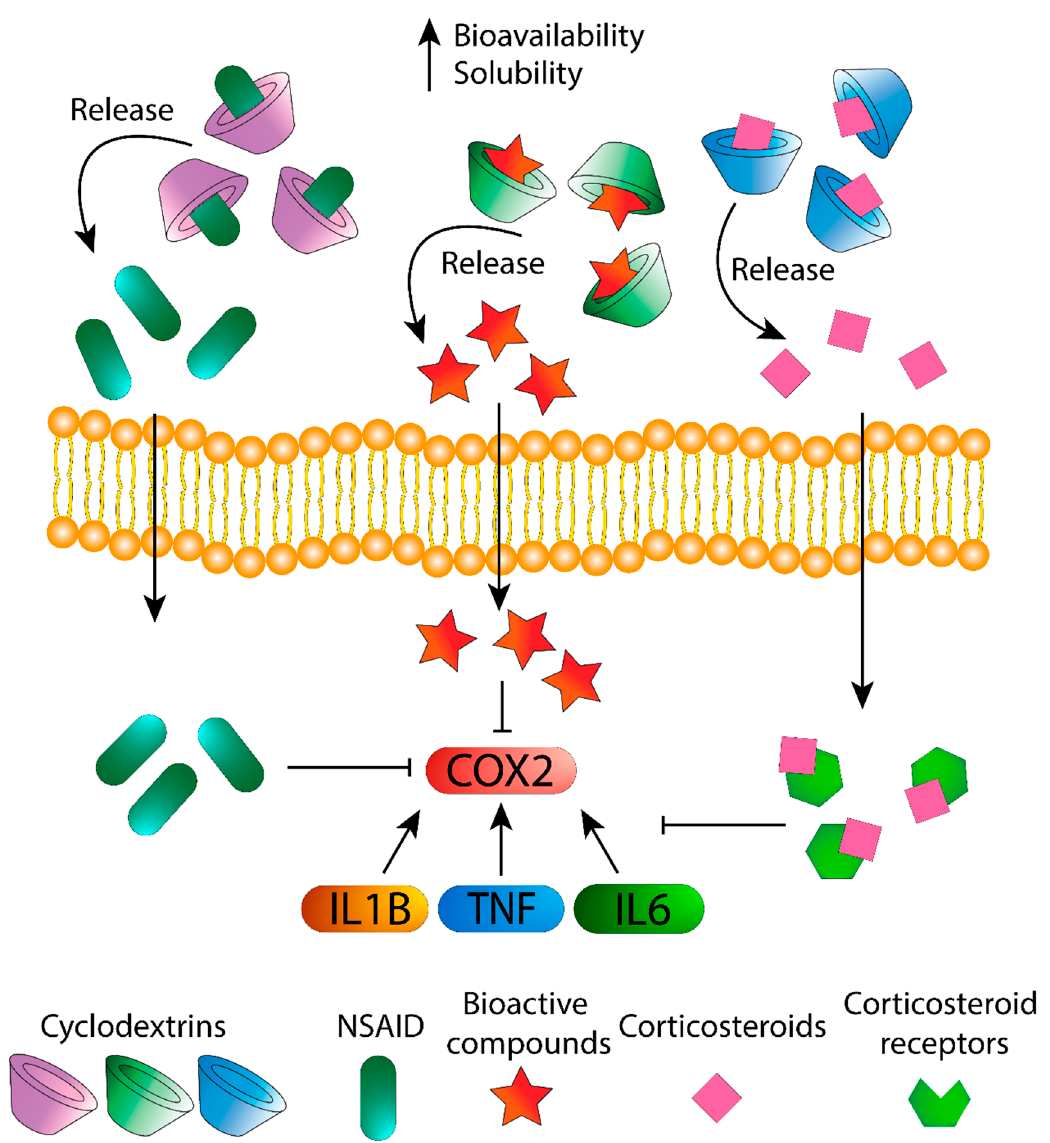
Figure 1. Schematic representation of CD/Corticosteroids and some CD/bioactive compounds complexes against inflam- mation (depending on the molecule, the pathway could change).